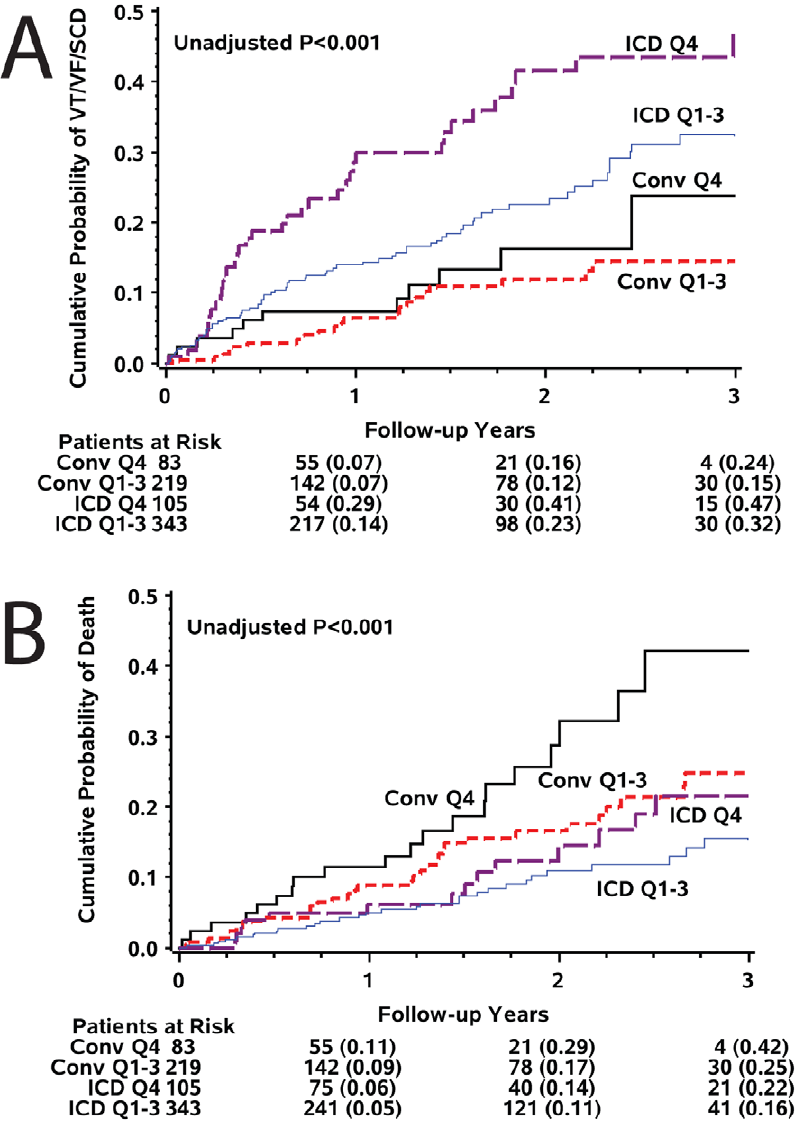
Figure 4. Kaplan-Meier curves for the probability of (A) sudden arrhythmic death, and (B) all-cause mortality in patients with the highest SAI QRST quartile and those with the lower 3 SAI QRST quartiles, by MADIT II study arm (ICD arm and conventional medical therapy arm).